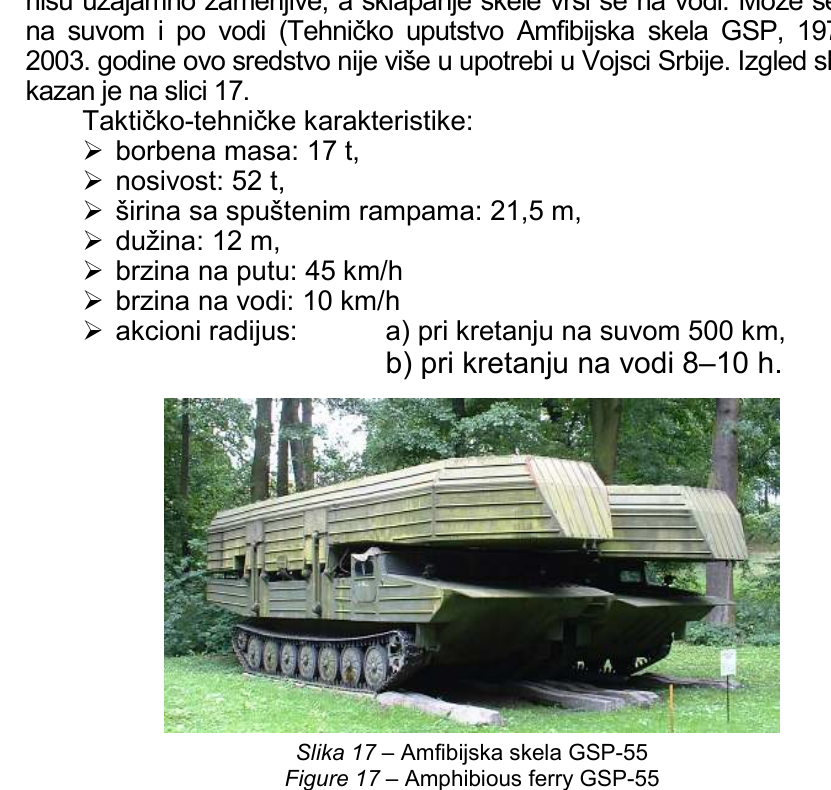
Figure 17 – Amphibious ferry